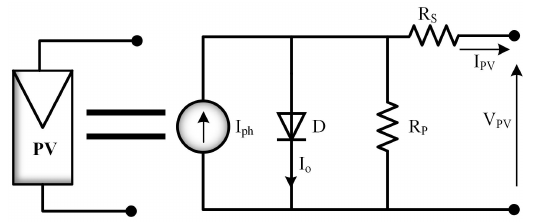
Figure 4. PV array equivalent